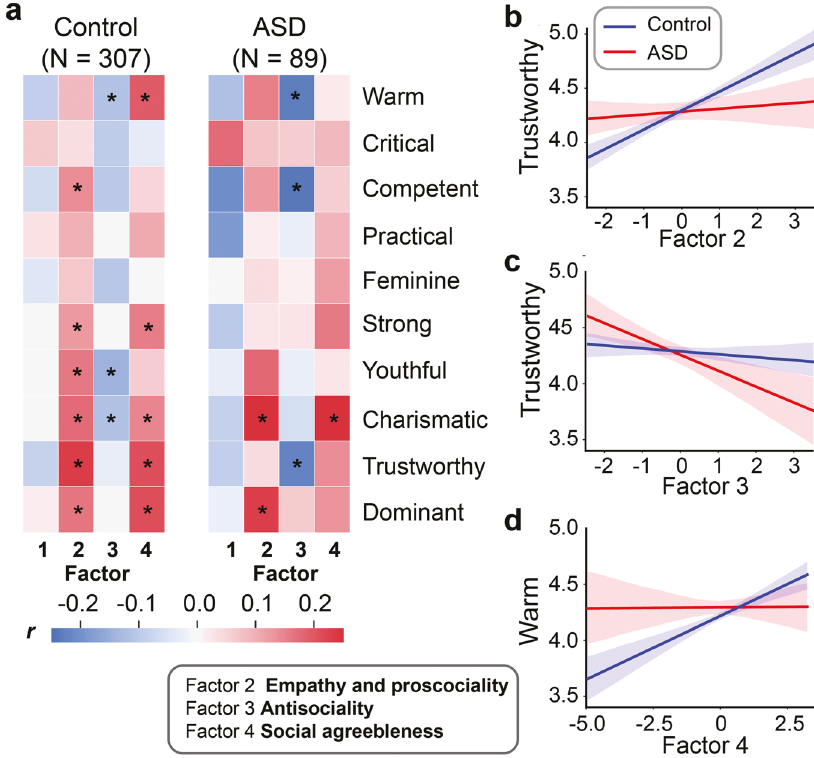
Fig. 5 Results of the regression analysis. Correlations between factor scores and social trait judgments ( a ). Scores of Factor 2 ( b ) and Factor 3 ( c ) are differentially associated with the Trustworthy judgment in the control group relative to the ASD group. Scores of Factor 4 ( d ) are differentially associated with the Warm judgment in the control group relative to the ASD